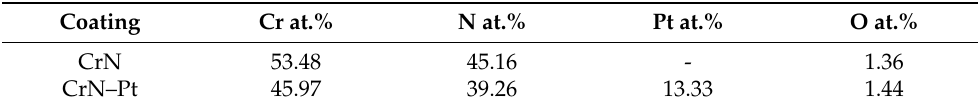
Table 1. Compositions of the CrN and CrN – Pt coatings. Coating Cr at.%